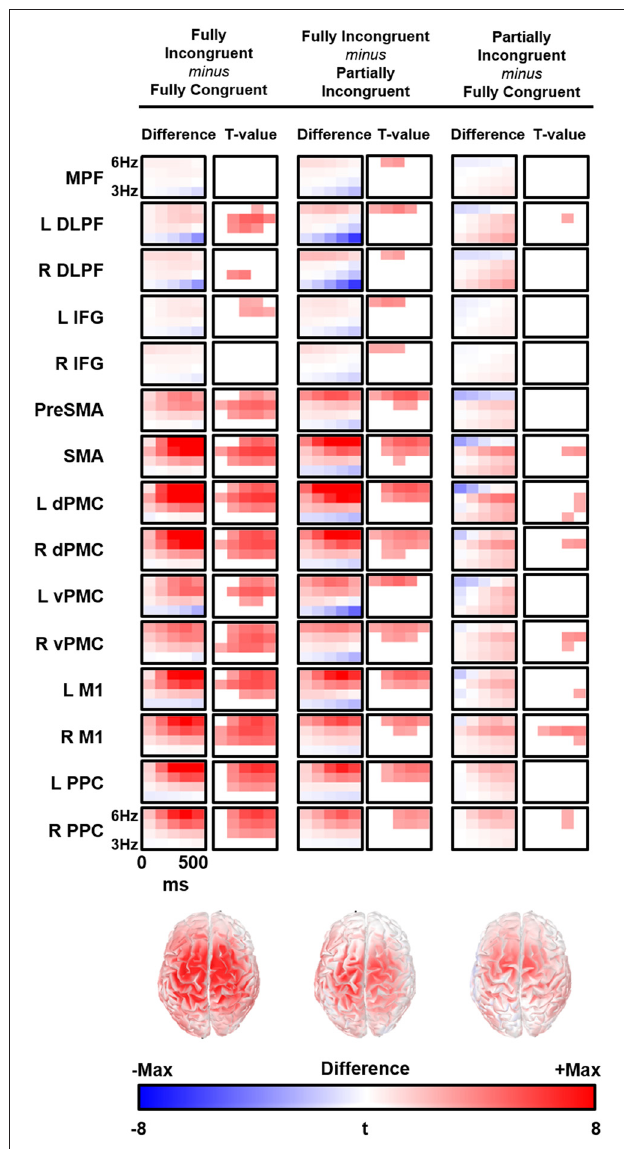
FIGURE 4 | Time-frequency (TF) difference (left column) and the corresponding t-map (right column) is shown for each regions of interest (ROIs). The maps of the t -value are thresholded at Bonferroni corrected p < 0.05. Bottom line shows the cortical distribution of theta activity difference between conditions at 300 ms and 5 Hz. R, Right; L, Left; MPFC, Bilateral Medial PreFrontal Cortex; DLPF, Dorsolateral PreFrontal; IFG, Inferior Frontal Gyrus; PreSMA, Bilteral Pre Supplementary Motor Area; SMA, Bilateral Supplementary Motor Area; dPMC, Dorsal PreMotor Cortex; vPMC, Ventral PreMotor Cortex; M1, Primary Motor Cortex; PPC, Posterior Parietal Cortex.